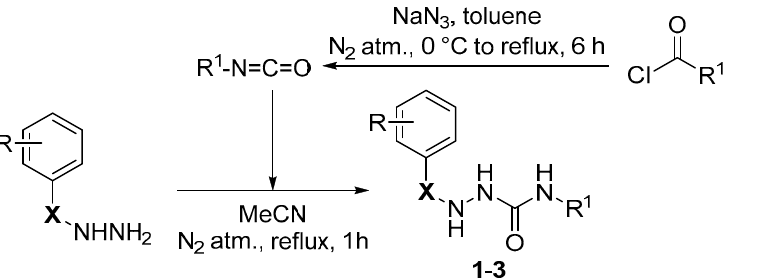
Table 2. Inhibition of AChE and BChE, selectivity indexes and lipophilicity of hydrazinecarboxamides 1–3 .